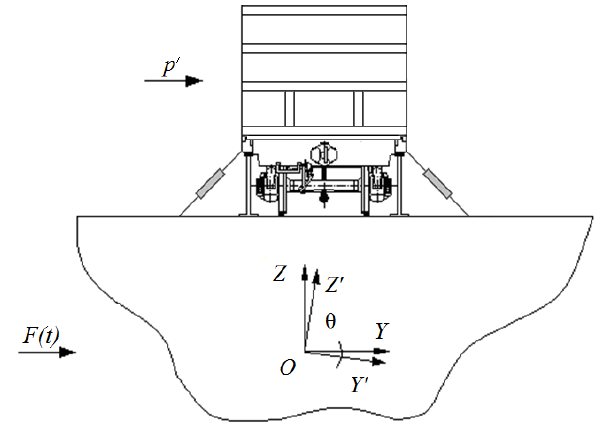
Figure 20. Calculation scheme.